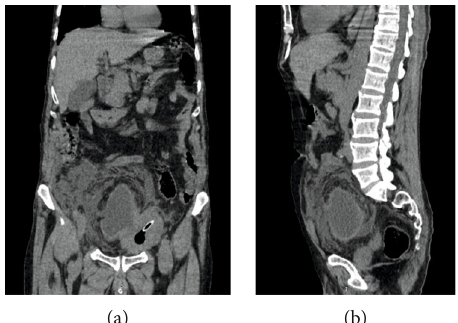
Figure 3: (a) Coronal reconstruction of the CT scan showing empty bladder with small amount of intra-abdominal fl uid leaking from a ruptured large bladder diverticulum and perivesical fat in fi ltration. (b) Sagittal reconstruction of the CT scan showing a large full ruptured bladder diverticulum with fl uid collection around it and ureteral